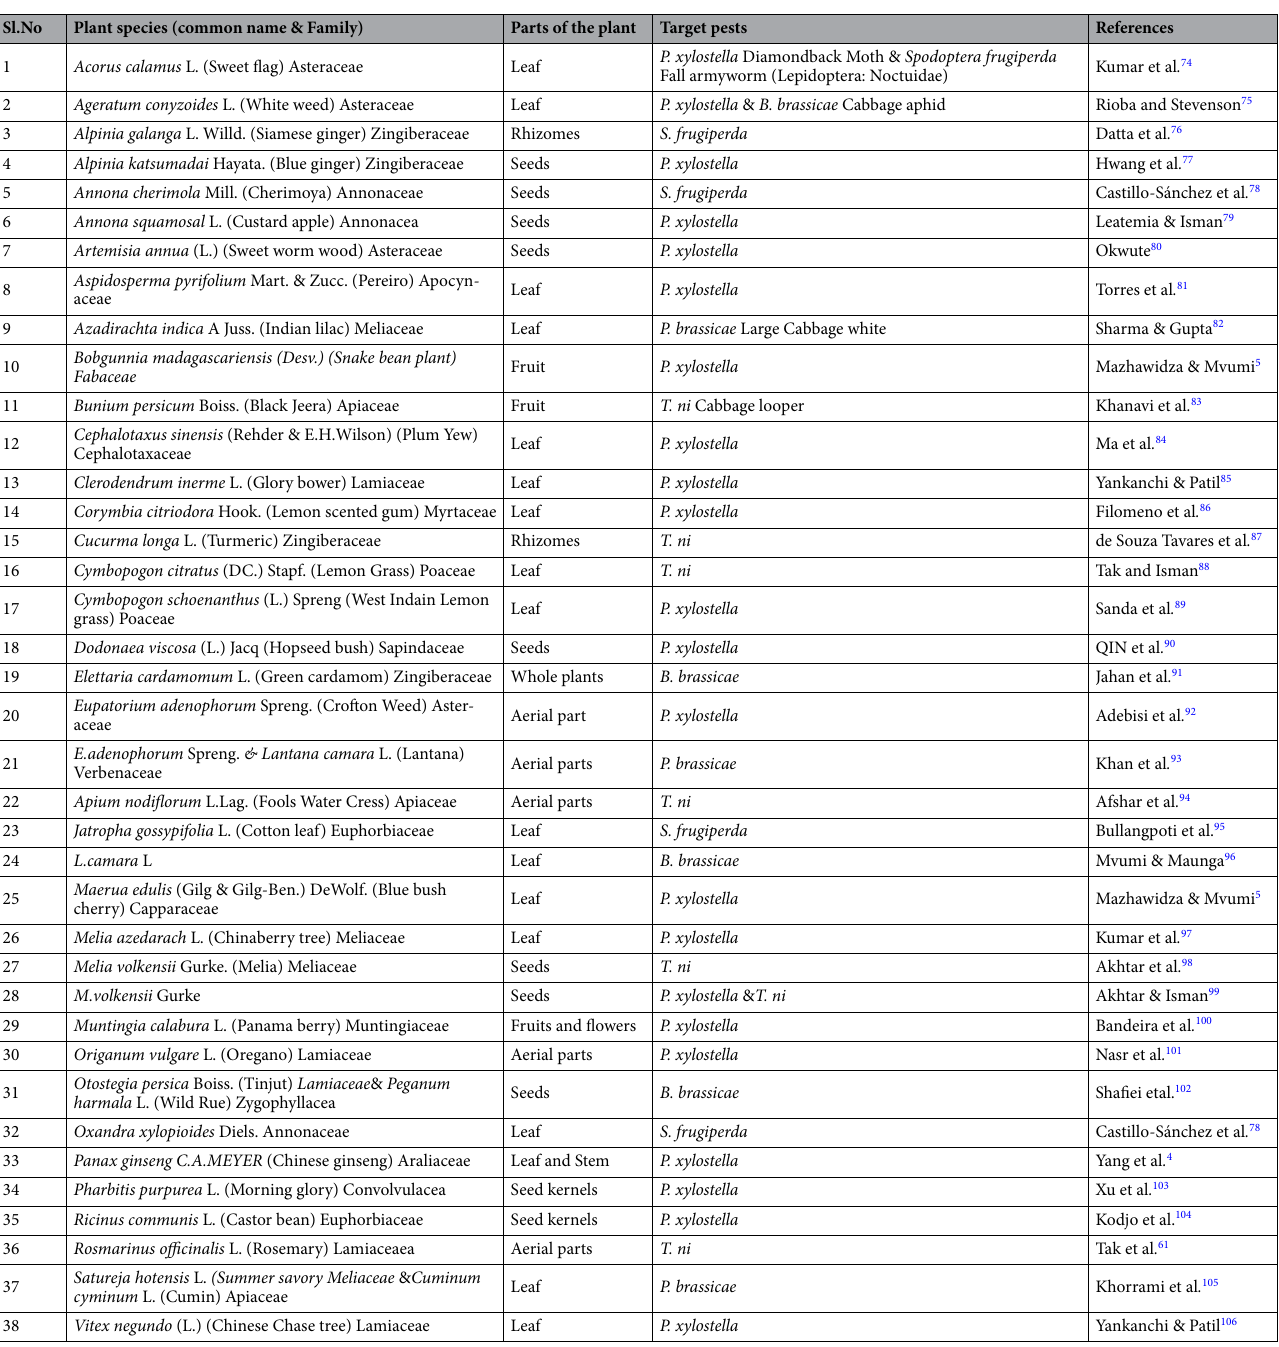
Table 1. List of some of the insecticidal plants used in management of crucifer